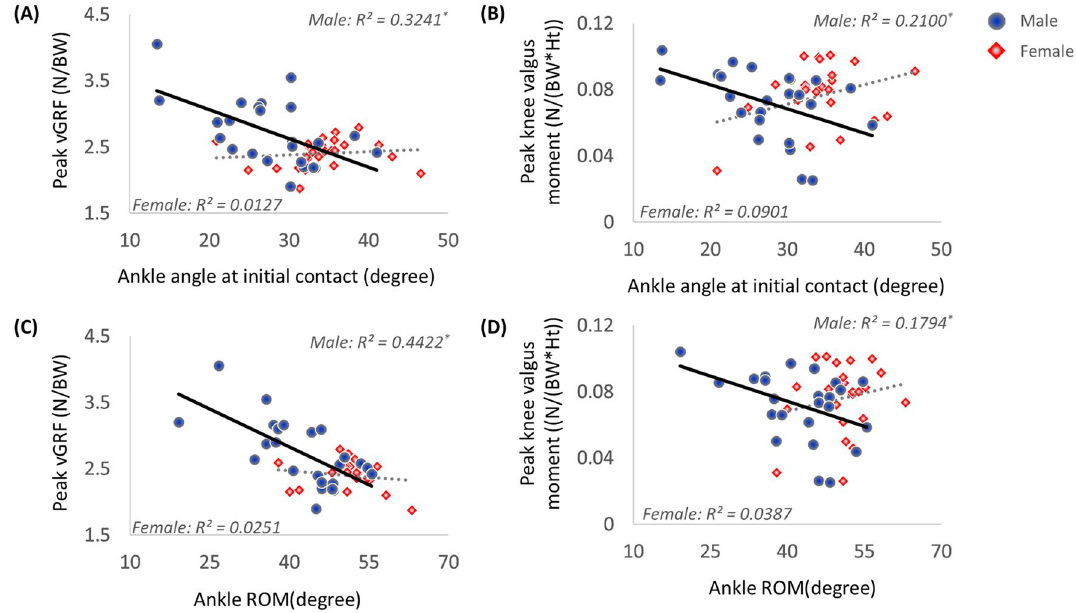
Figure 1. Relationships between peak vGRF and knee valgus moment and ankle kinematics in sagittal plane. Scatter plots depicting the relationship between ankle plantarflexion angle at initial contact and ( A ) peak vGRF and ( B ) knee valgus moment. Scatter plots depicting relationship between ankle ROM in sagittal plane and ( C ) peak vGRF and ( D ) knee valgus moment.